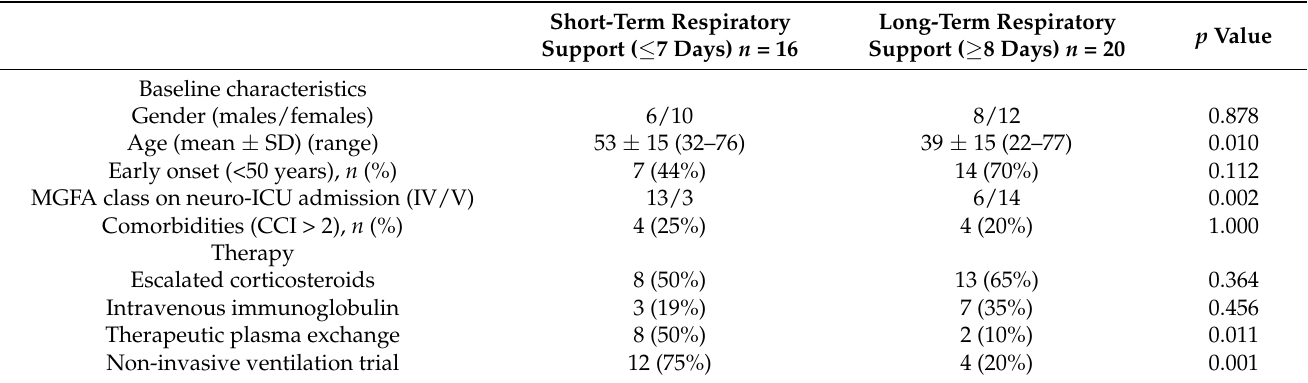
Table 3. Potential factors of clinical relevance to short-term respiratory support during MG acute exacerbations (MGFA—Myasthenia Gravis Foundation of America; ICU—intensive care unit; CCI—